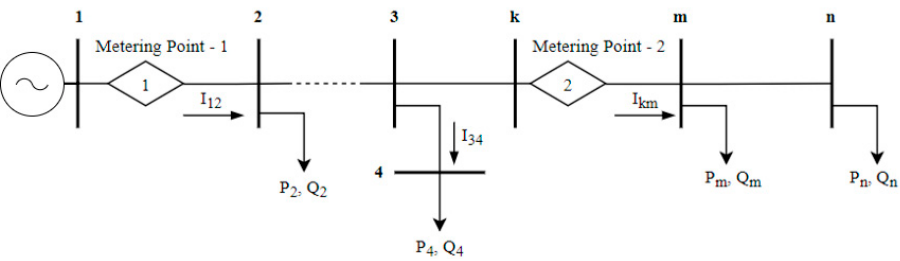
Figure 1. Simplified representation of a primary distribution network.